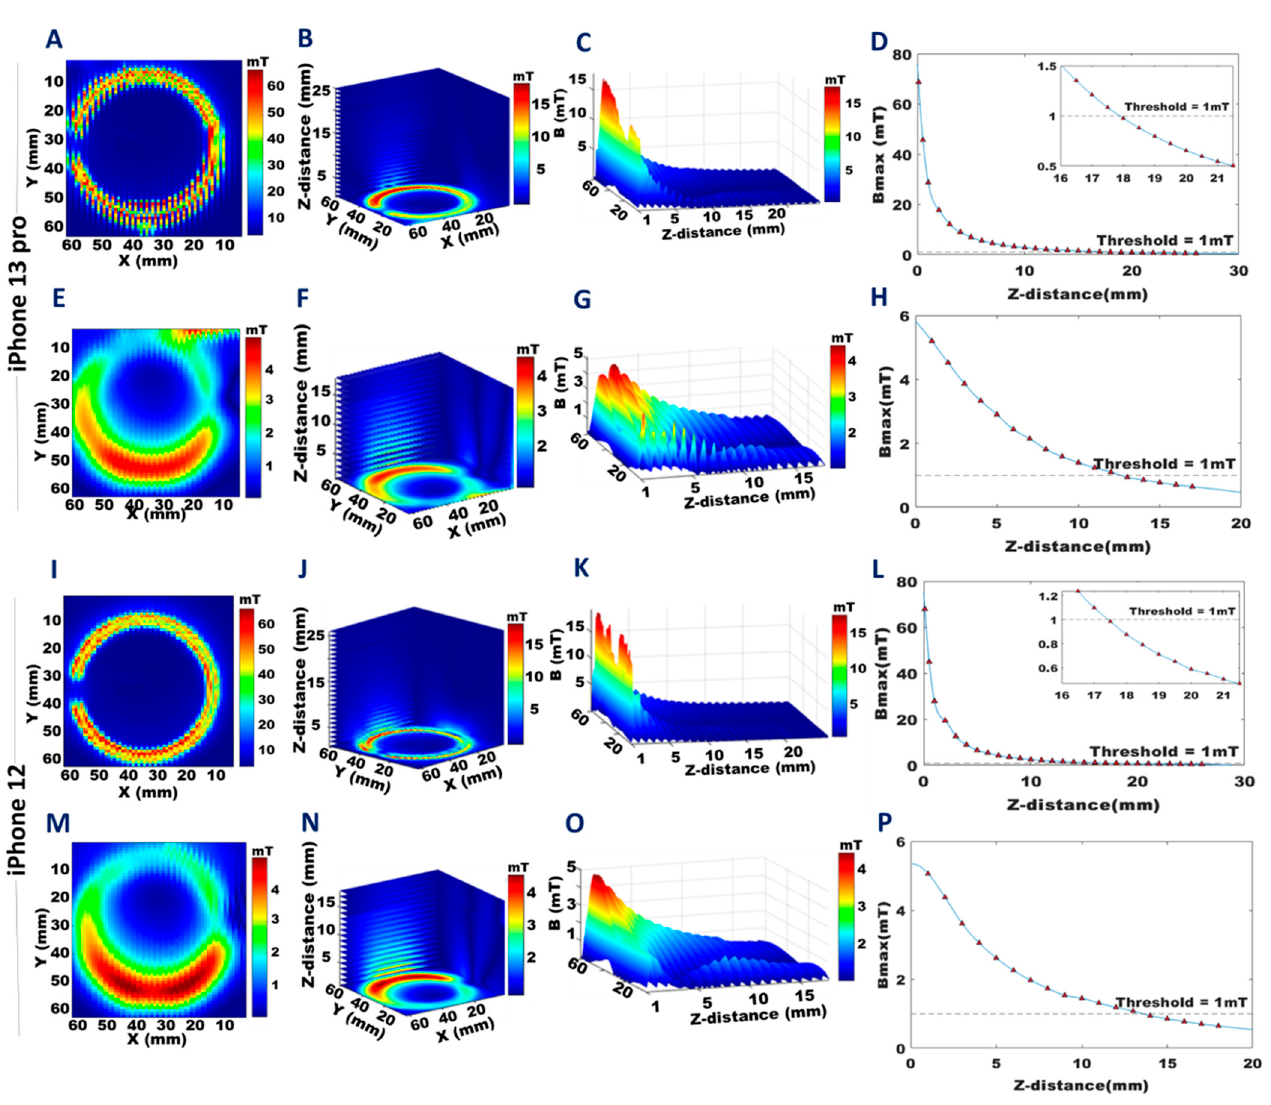
Figure 4. Distribution of stray magnetic fields obtained for the annular array of magnets for the front and back plane of the iPhone 13 Pro and the iPhone 12. The colors represent the strength of the magnetic field and are scaled to the maximum B-field of each dataset. A , E , I , and M : The 2D distribution of the stray magnetic fields for a transversal plane located at a distance of 0.1 mm from the back ( A ), ( I ) and at a distance of 1 mm from the front ( E ), ( M ) of the iPhone 13 Pro and iPhone 12. B , F , J , and N : The 3D distribution of the stray magnetic field for a transversal plane with a z-distance of 1–25 mm from the back ( B ), ( J ), and 1–18 mm from the front ( F ), ( N ) of the iPhone 13 Pro and the iPhone 12. C , G , K , and O : The 3D stray magnetic field (B) variation with increasing z-distance from the back ( C ), ( K ) plane, and from the front ( G ), ( O ) of the iPhone 13 Pro and the iPhone 12. D , H , L , and P : Maximum stray magnetic field (B max ) versus z-distance from the back ( D ), ( L ), and from the front ( H ), ( P ) of the iPhone 13 Pro and the iPhone